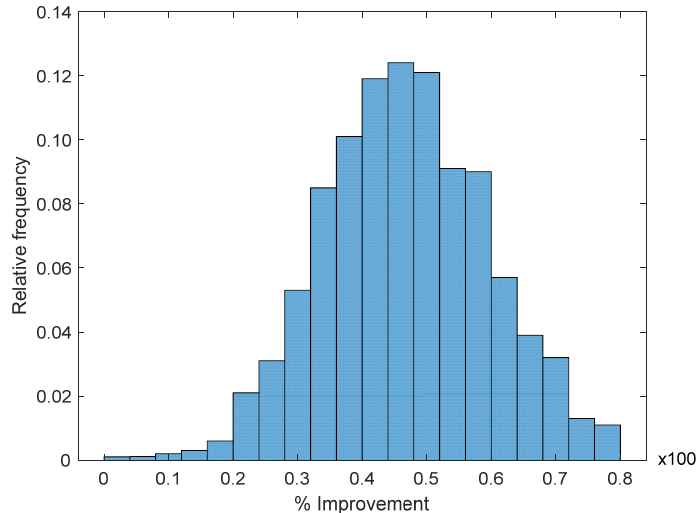
12 of 16 Figure 6. Normalized mean squared error ε / r max vs. exponentially distributed distance error with parameter λ , considering four ANs, single and mean recursive localization and r max = 10 m. In Figure 7, we present the histogram of the improvement percentage ρ , obtained